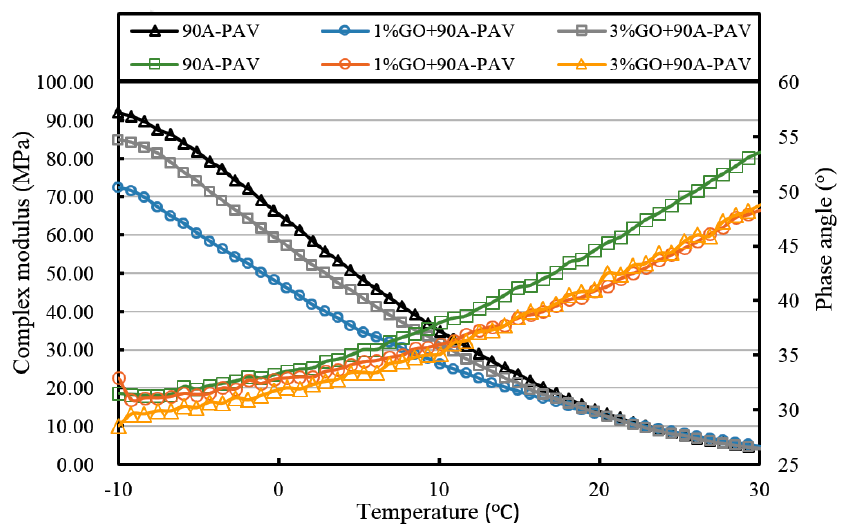
Figure 18. Complex modulus and phase angle of GO-modified 90A and its matrix at low temperature after PAV aging.